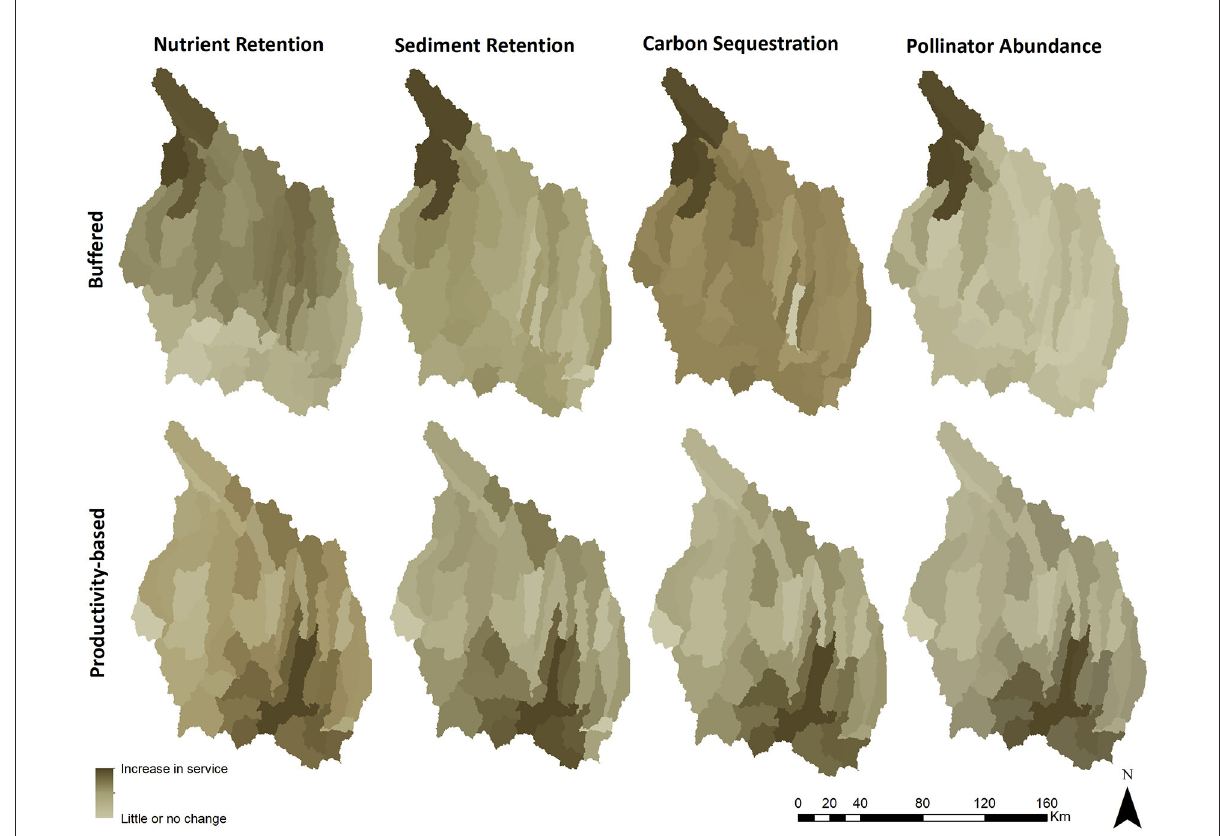
FIGURE2 Changes in ecosystem services across the Grand River Basin (IA and MO, USA) for Buffered and Productivity-based scenarios compared to current land use/land cover